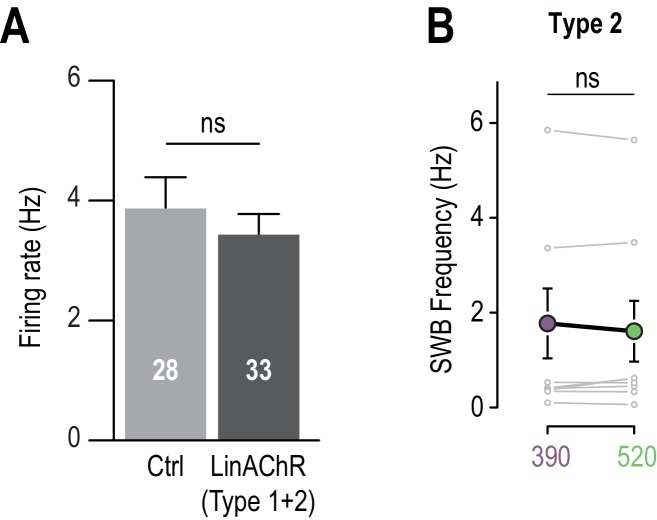
Photocontrolling VTA β2LinAChRs in vivo.(A) Mean firing rate of control neurons (MAHoCh alone n = 28) is not significantly different from mean firing rate of transduced neurons (Type 1 and 2 are pooled, n = 33, p=0.96). (B) Average SWB frequency of all type 2 pDA neurons (n = 9) is similar in 390 and 520 nm light. All values represent mean ± SEM.